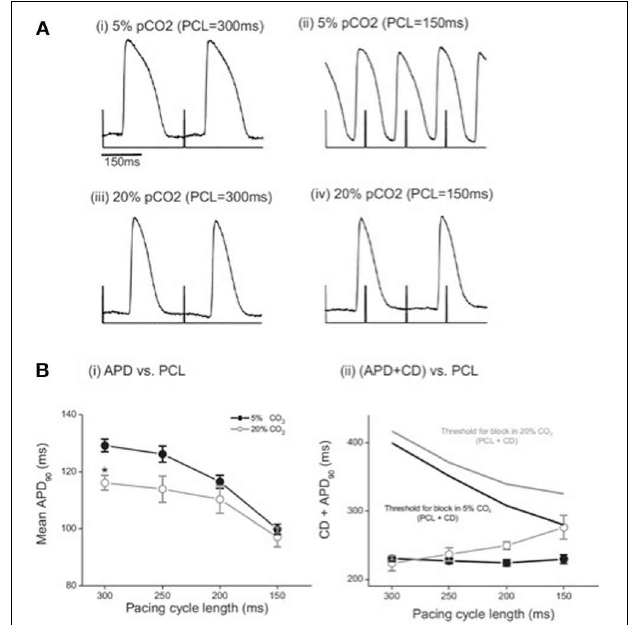
FIGURE 2 | (A) Examples of optical action potentials recorded from the epicardial surface under control conditions (5%CO 2 , pH 7.4) and during acidosis (20% CO 2 , pH 6.7). With right atrial pacing, and recording of optical action potentials on the epicardial surface of the ventricle, note the 2:1 relationship of the stimulus artifact to the optical action potential at PCL 150ms in 20% CO 2 demonstrating conduction block from atrium to ventricle. (B) (i) Effect of acidosis on mean APD 90 from right atrial pacing. The only significant change demonstrated was at 300ms. n = 5 except PCL 300ms where n = 3; ∗ = p < 0 . 05. (ii) Effect of acidosis on conduction delay (CD) and 90% action potential duration (APD 90 ) from right atrial pacing. As the PCL was decreased in normal pH conditions, there was no significant change in the sum of CD and APD 90 . In acidic conditions, the sum of CD and APD 90 increased ( n = 5 except PCL 300ms where n = 3; ∗ p < 0 .